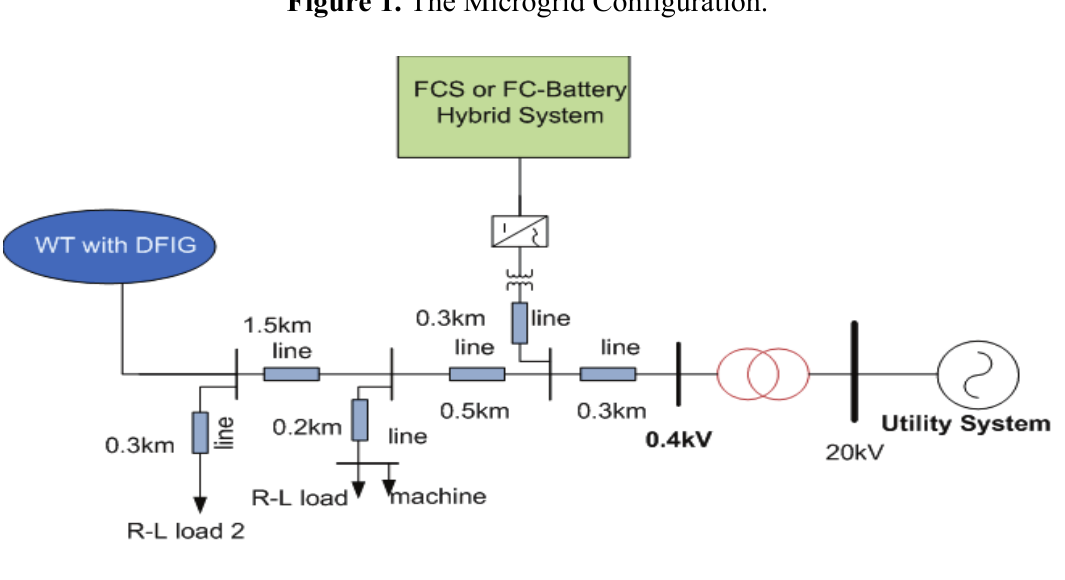
Figure 1. The Microgrid